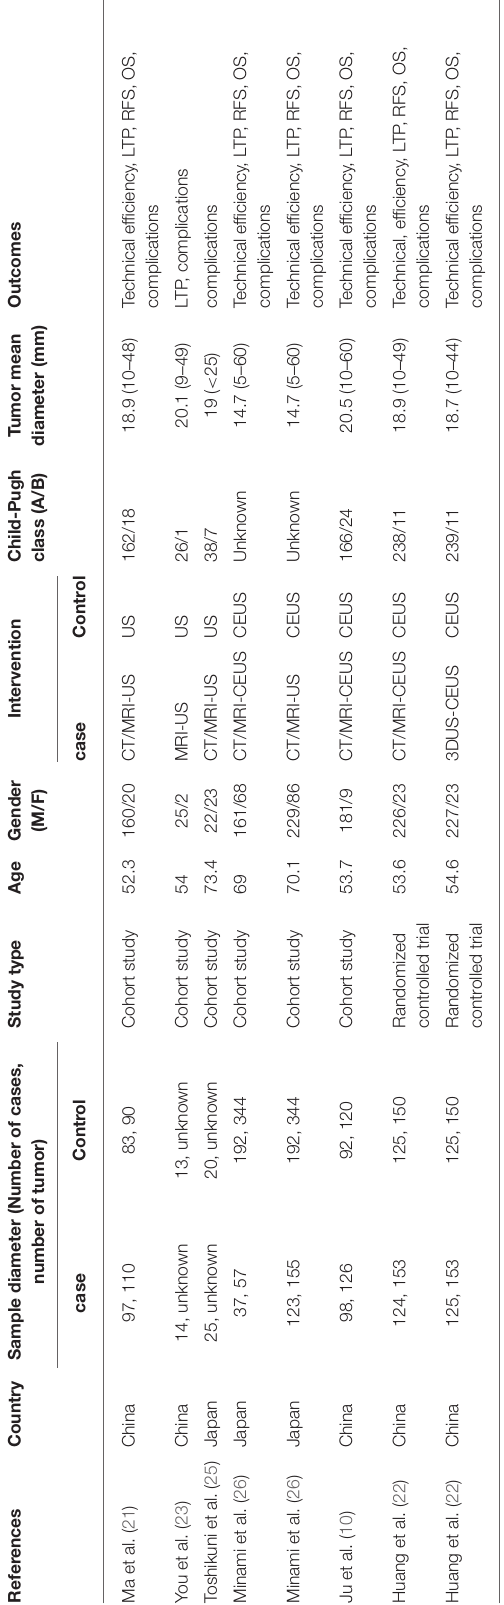
( Figure 3B ), with a heterogeneity of ( I 2 = 60.0%, p = 0.03). When the metaanalysis was subgrouped by mean diameter, heterogeneity was attenuated in studies with ≥ 15 mm ( I 2 = 40%, p = 0.17, test for overall effect: z = 2.99, p = 0.003), and in studies with < 15 mm ( I 2 = 0%, p = 0.67). Then, there was a significant between-subgroup heterogeneity ( I 2 = 84.3%, p = 0.01). To examine the effect of each study on pooled effect diameter, we performed sensitivity analyses and found that (26) (2)’s study (26) altered the overall effect diameter (OR, RE: 0.50; 95% CI: 0.31, 0.82, p =